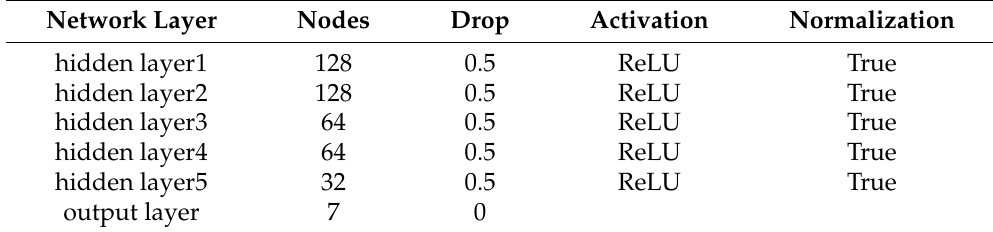
Figure 3. The structure of the neural network we built, which consists of five hidden layers and input and output layers. Table 1. Structure of the audio